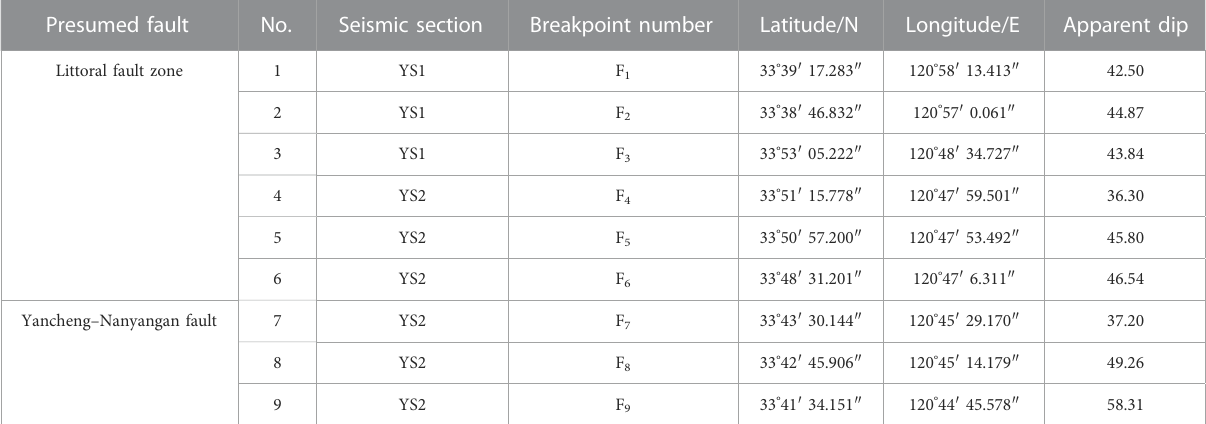
TABLE 2 List of recognition breakpoints in YS1 and YS2. Presumed fault No. Seismic